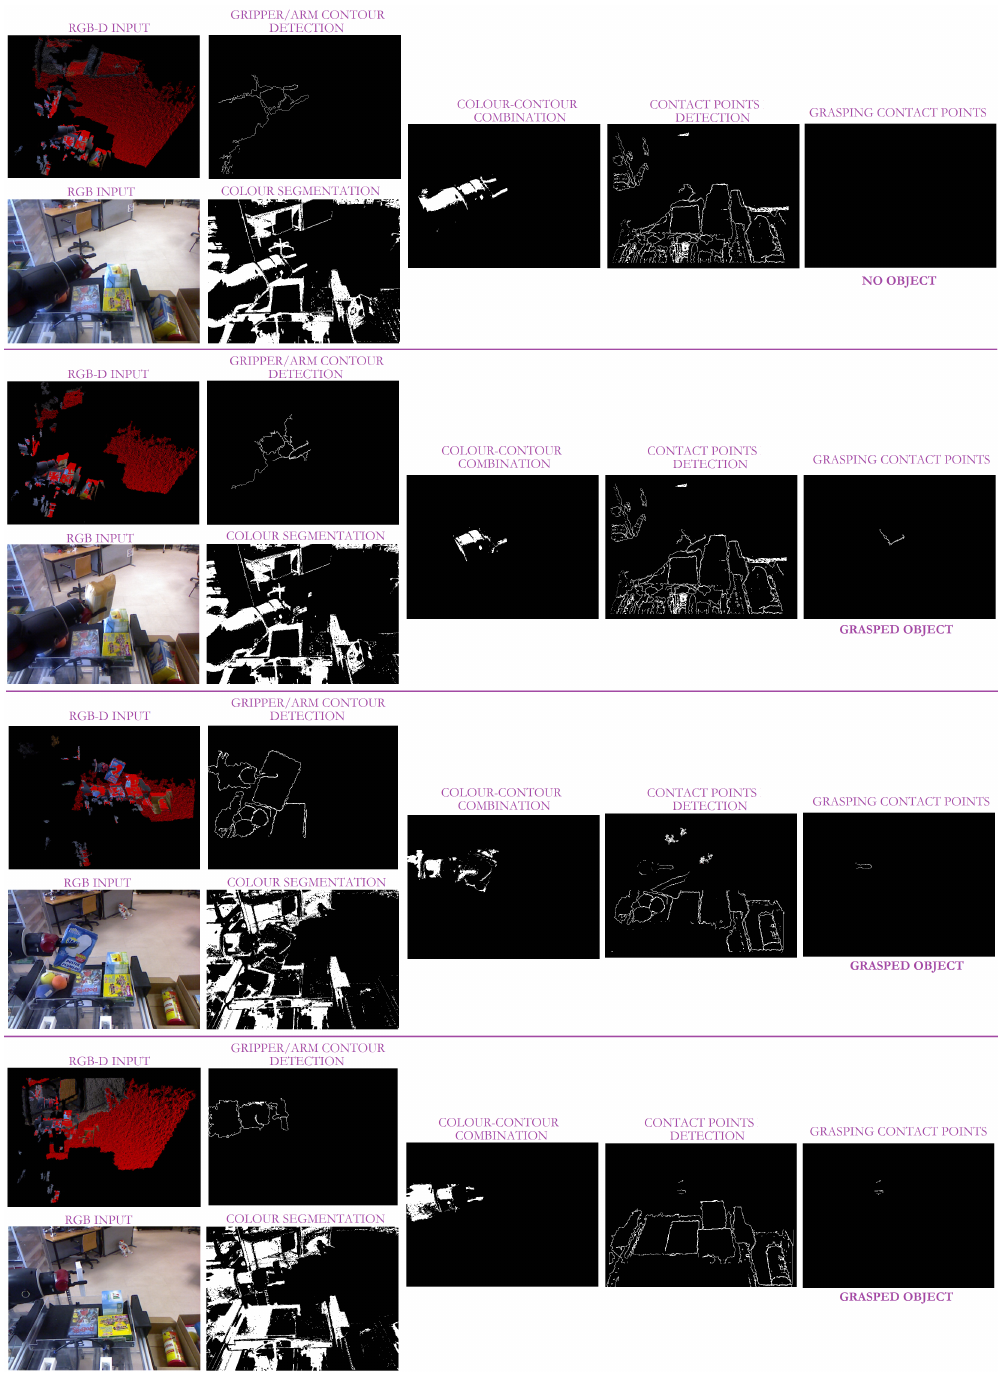
Figure 10. Some experimental results of our approach with the Baxter robot in pick-and-place tasks. The first column corresponds to the taken RGB-D image given as an RGB image and a depth map. The second column illustrates the Lab segmentation with the robot arm contour obtained from the contour segmentation refinement. The third column illustrates the combination of the images in the two columns. The next column depicts all the two-object contact points based on depth proximity. The last image shows the contact points obtained from the overlap between the results in the third and fourth